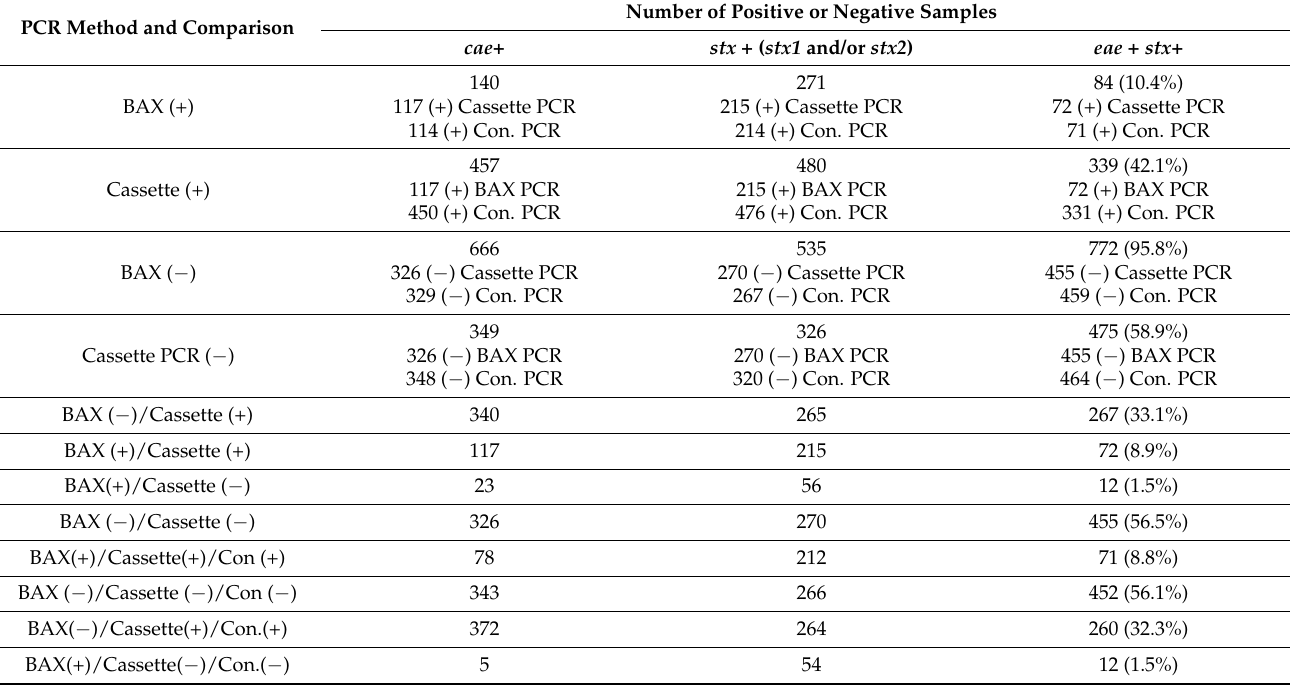
Table 1. Comparison between cassette PCR, BAX PCR and conventional PCR (Con. PCR) data with 806 beef carcass swab samples for PCRs performed with eae primers (column 2) and stx primers (column 3). Column 4 shows the number of indicated swabs for each box that harbored both eae and stx templates.